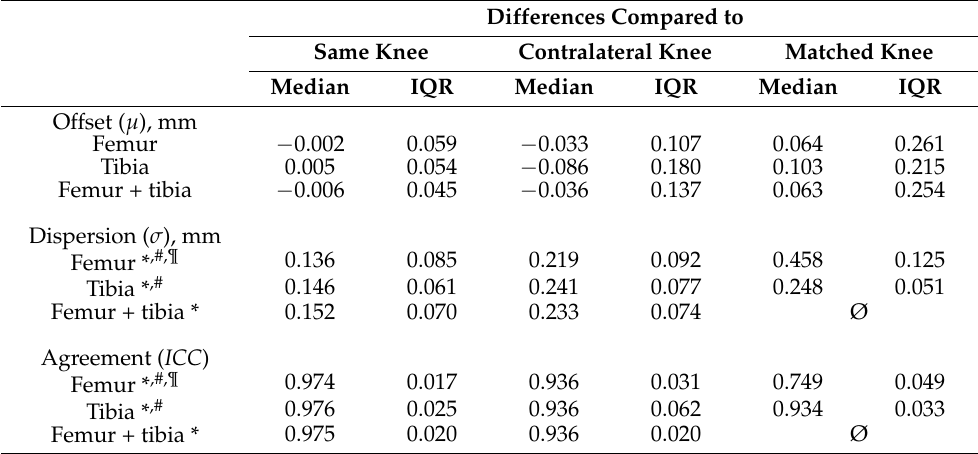
Table 2. Differences among 2D Anatomically Standardized CTh Maps for Three Comparison